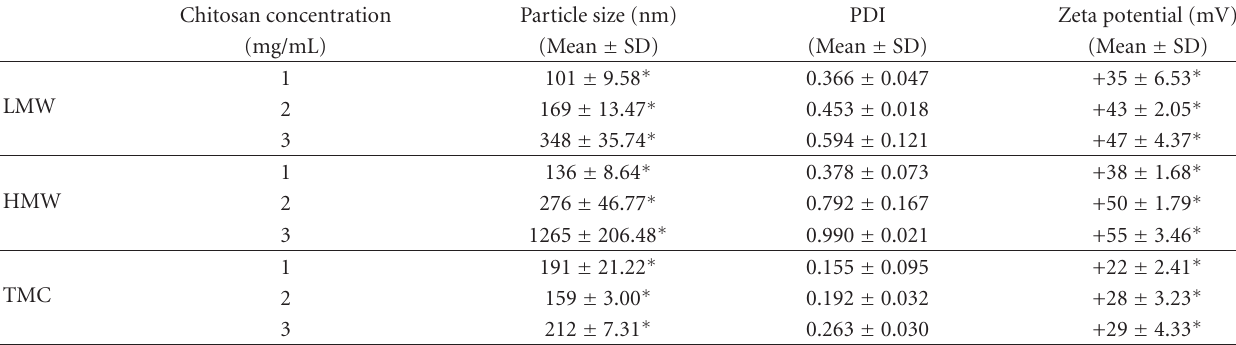
Table 1: Mean particle size, PDI, and zeta potential of di ff erent concentrations (mg/mL) for chitosan and TMC nanoparticles with constant amount of 0.1% w/v TPP before centrifugation, n = 3.